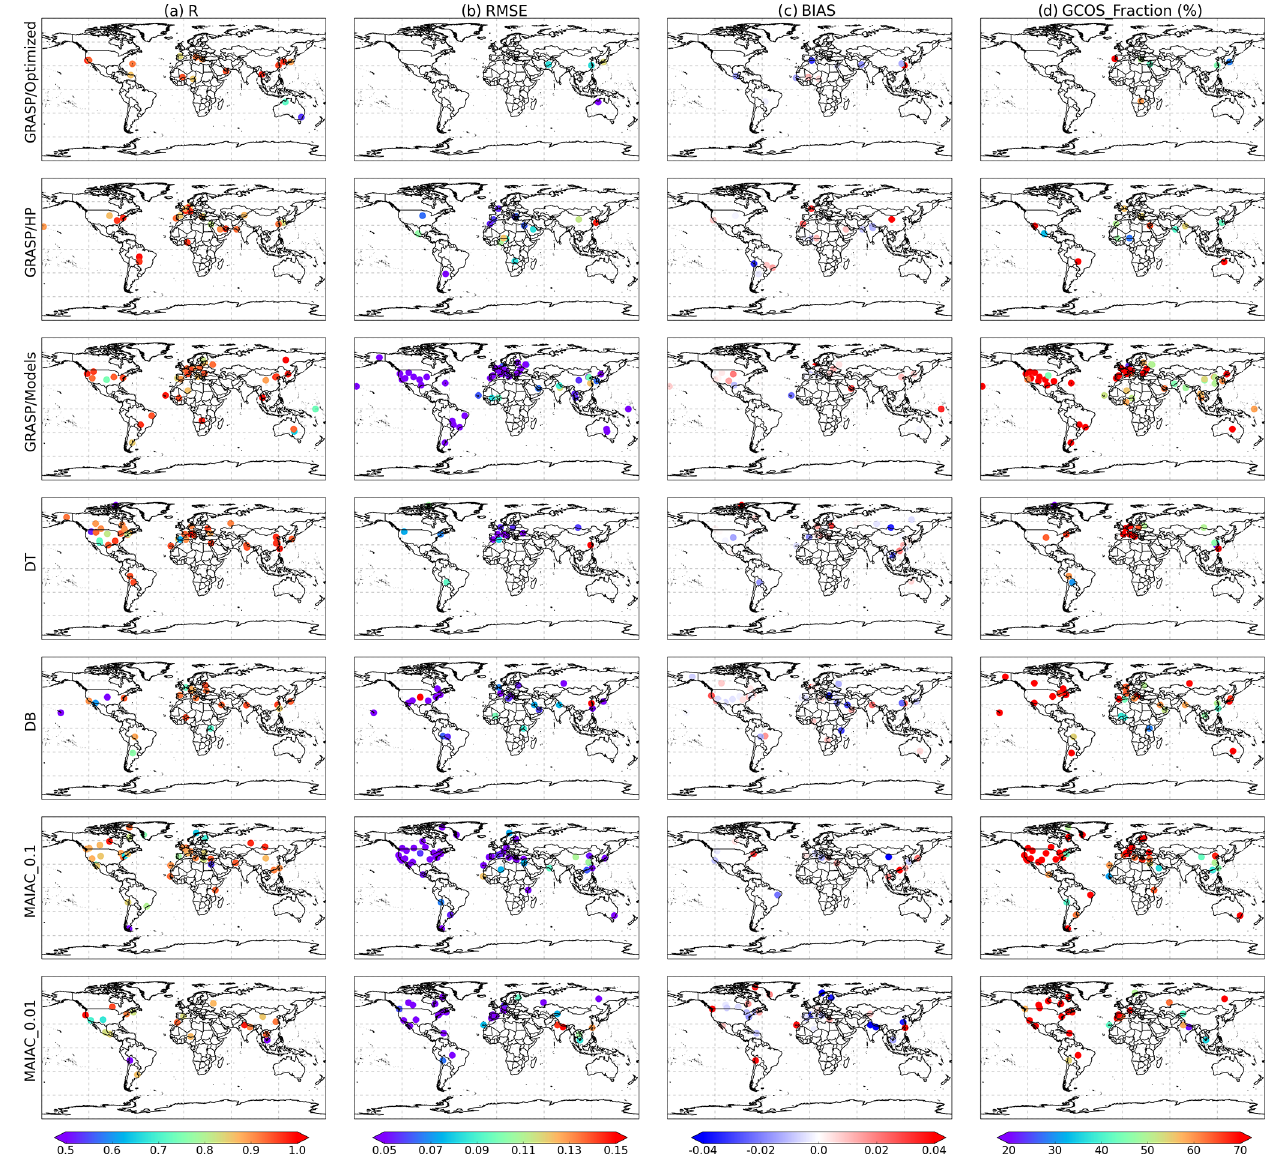
Figure 18. Maps showing statistical metrics (a) R , (b) RMSE, (c) bias, (d) GCOS fraction (%) for the best performing AOD products (first ranking statistics among seven PARASOL/GRASP and MODIS products) over each AERONET site. Note that only the first ranking statistics over each site are present in the